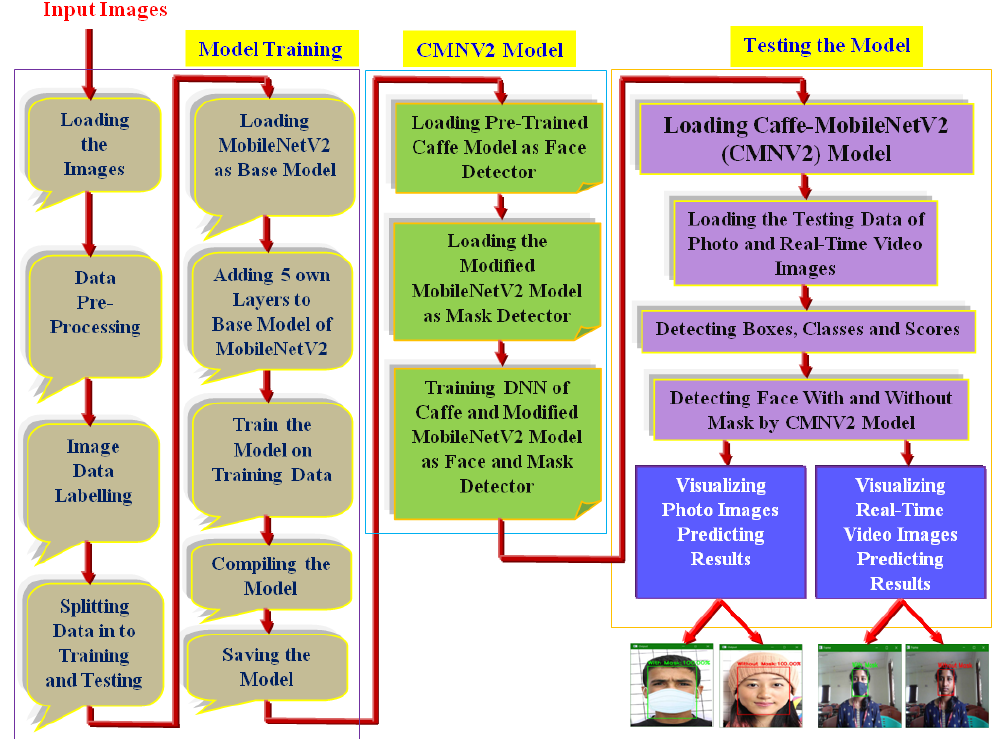
Figure 8. Flow of the